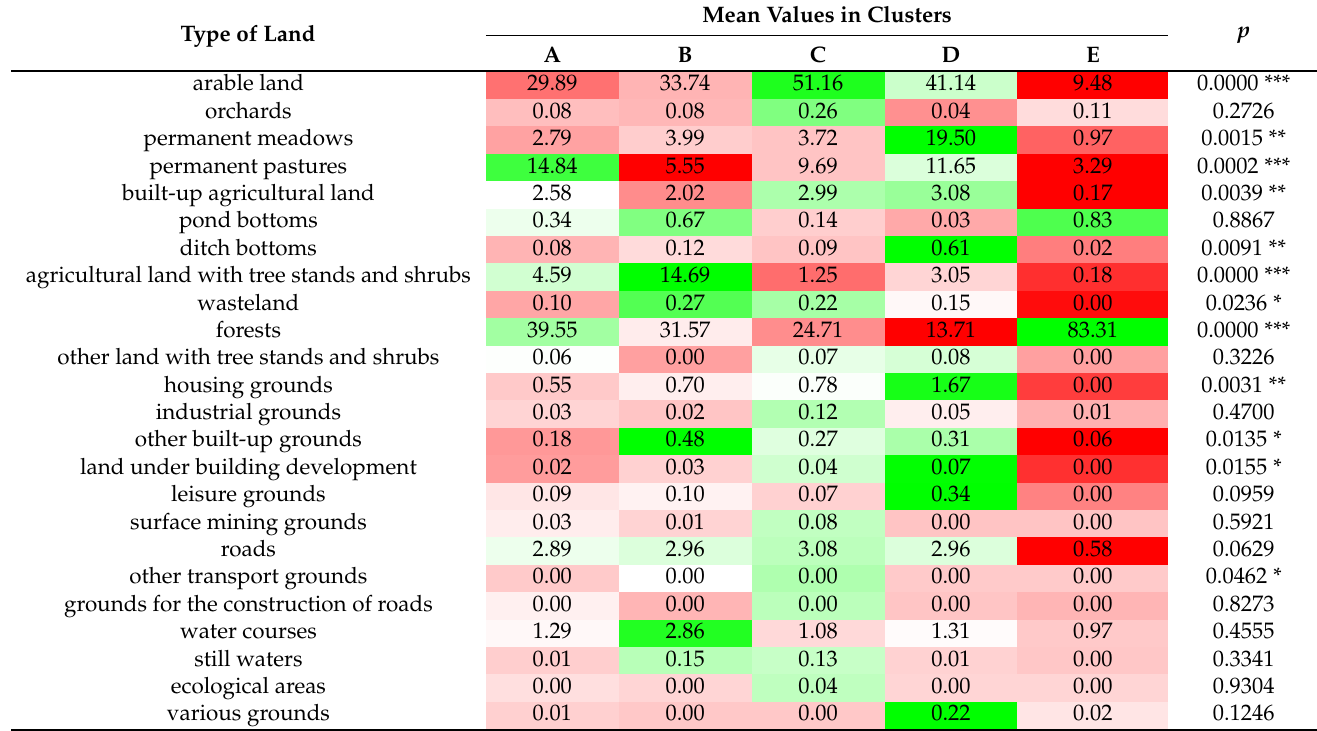
Table 4. Mean values in village clusters identified using the complete-linkage